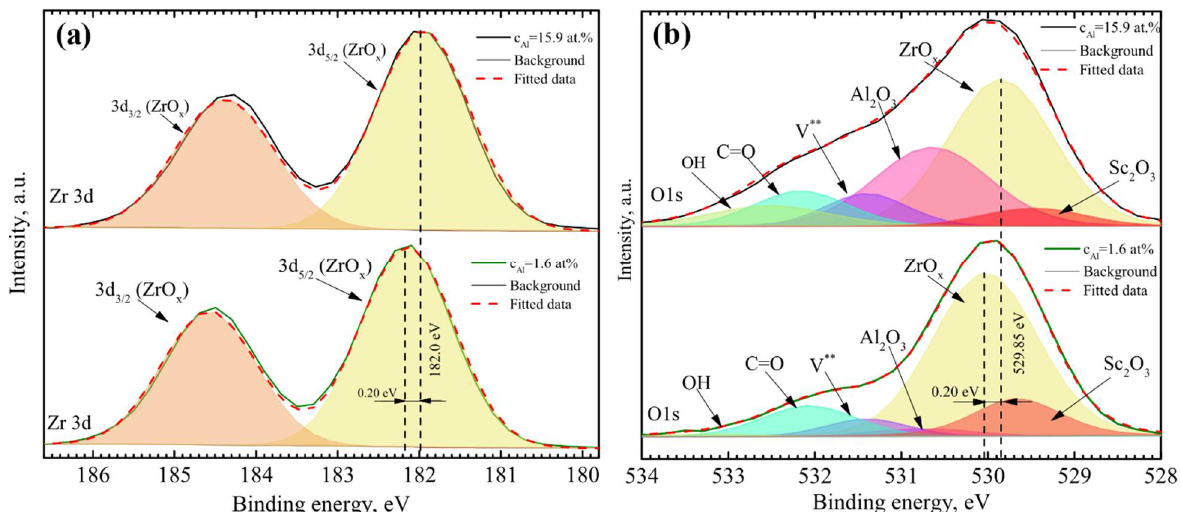
Figure 1. XPS spectra of ScAlSZ thin films: ( a ) Zr 3d and ( b ) O 1s. The AFM measurements were done to investigate the influence of Al concentration on the microstructure. Thin films containing low Al concentration (e.g., 1.6 at.%) have a fiber-like structure and roughness of 4.0 nm (Figures 2a and 5). The transition from fiber-like to grained structure occurs at higher Al concentrations (e.g., 15.9 at.%). In these cases, columns of ScAlSZ thin films consist of small grains (globulars) instead of fibers (Figure 2b) due to the inhibiting effect of Al or Al 2 O 3 phases in grain boundaries. The surface roughness also decreased from 4.0 to 1.9 nm with increasing Al concentration (Figure 5).